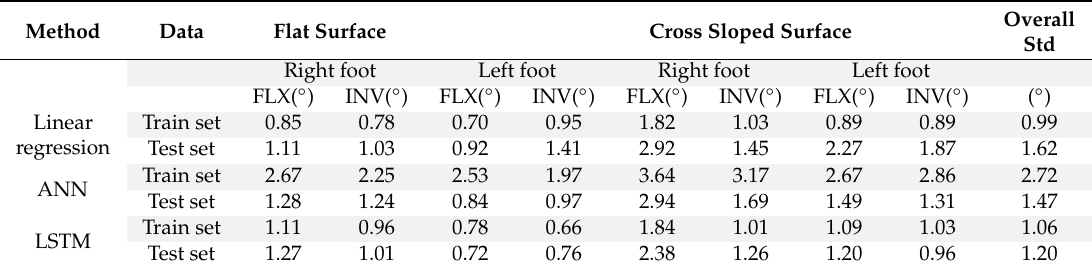
Table 2. Standard Deviation of RMSE values in degrees ( ◦ ) for Linear Regression and LSTM. The lower values indicate better performance (FLX = Flexion; INV =